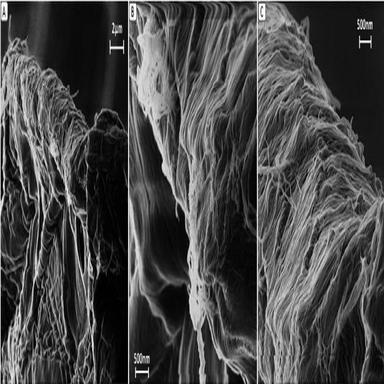
Various HIM micrographs on birch never dried, CPD treated pulp taken with a longer exposure time (3e5 min): a,b,c) individual nanofibrils and nanofibril bundles clearly visible.